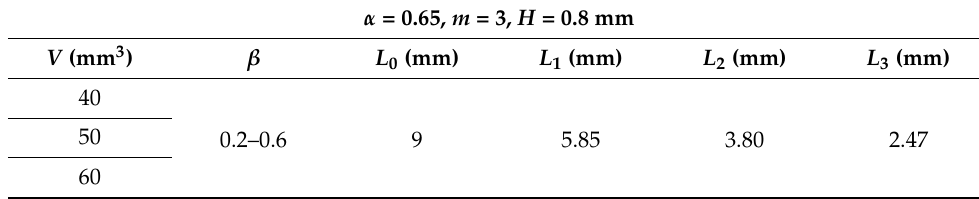
Table 5. Geometric parameters of branched HCM with different V